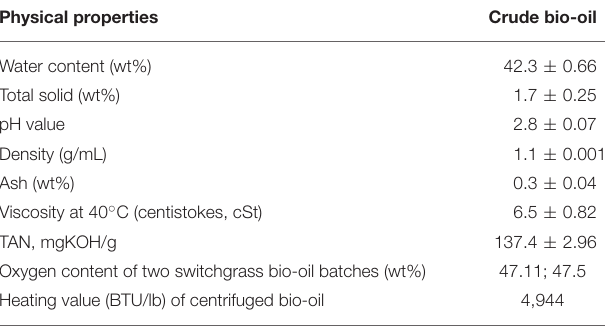
TABLE 1 | Physicochemical properties of switchgrass